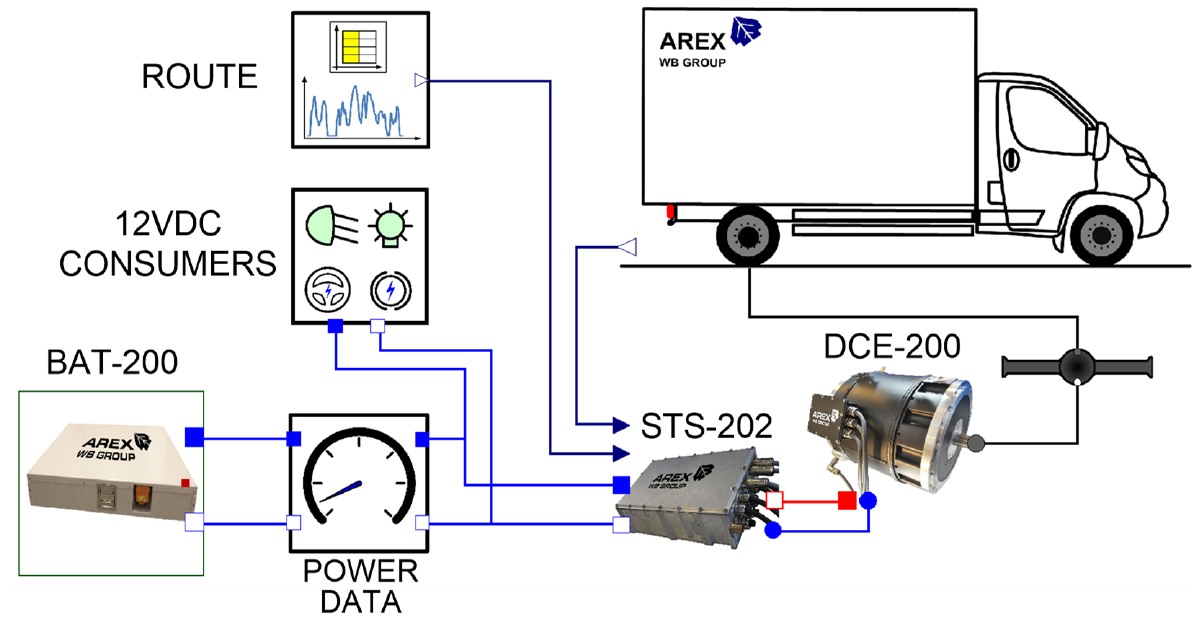
Figure 3. Model structure of eLCV electric powertrain with central motor (4 × 2).